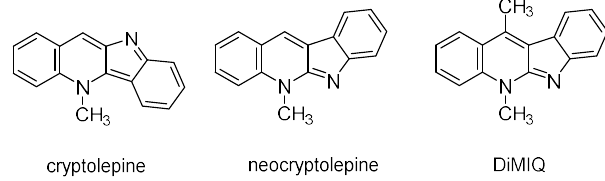
Figure 1. Structures of cryptolepine, neocryptolepine and DiMIQ.